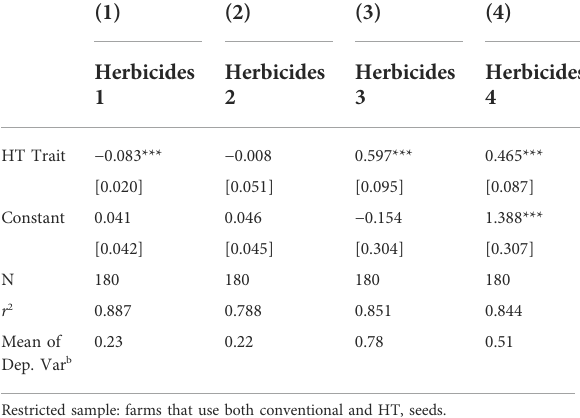
TABLE 3 OLS estimates of effects of HT trait on quantity (Kg/ha) of herbicides per toxicity